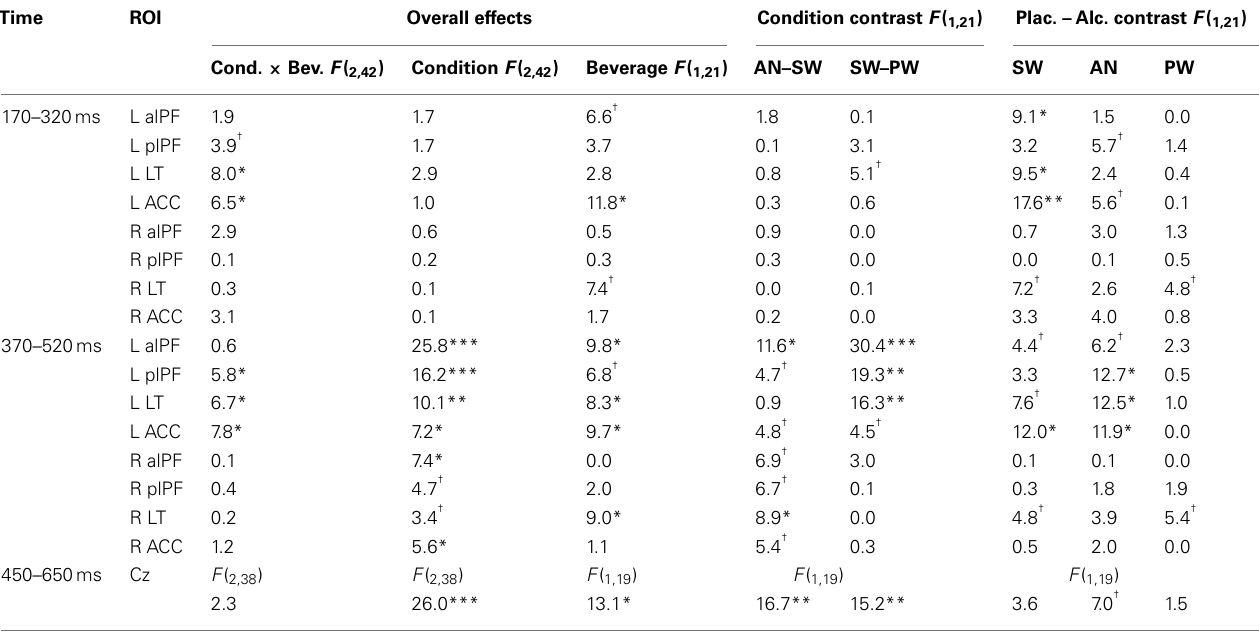
Table 1 | Summary of statistical comparisons of the MEG event-related theta for all left (L) and right (R) ROIs withinT2 andT3 time windows and EEG theta within 450–650ms latency expressed as F -values.